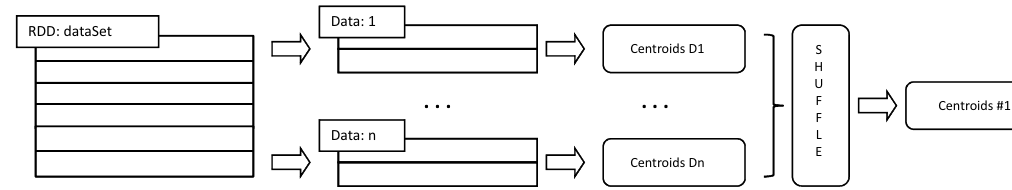
Figure 2. One concurrent execution of the k-means